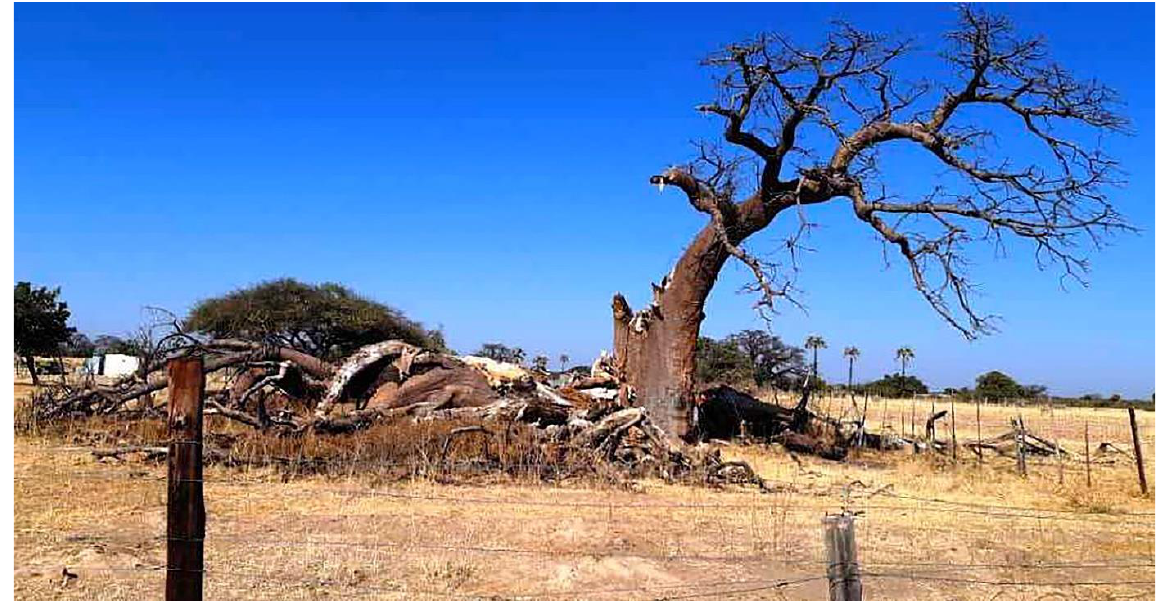
Figure 9. In July 2022, only one stem of the Amadhila baobab was still standing.